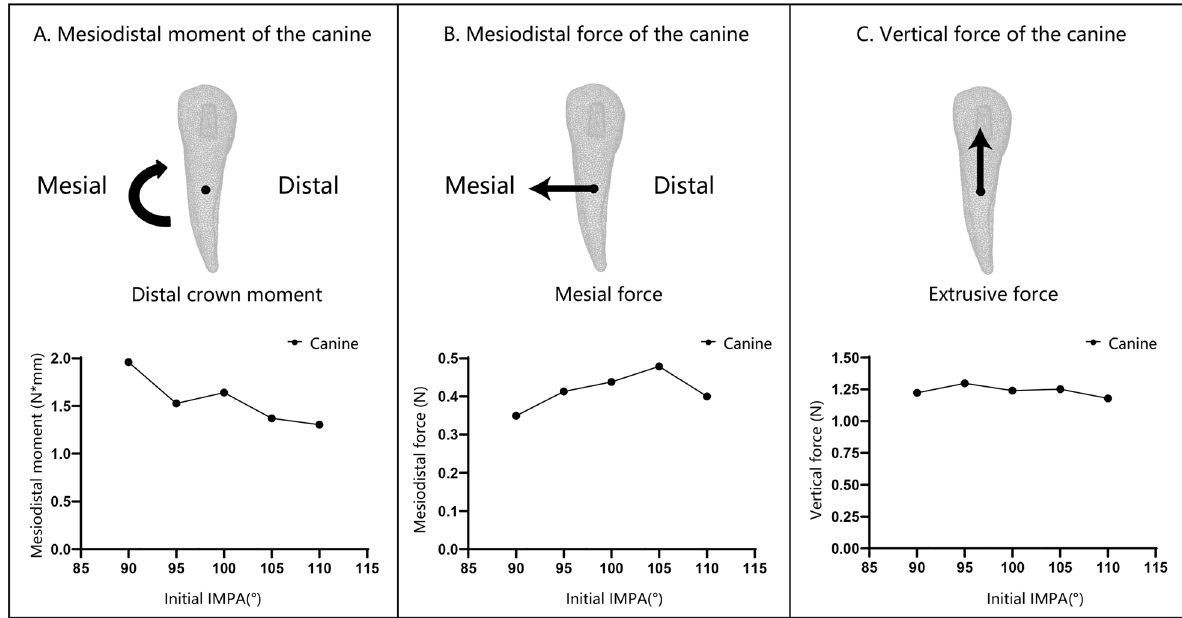
Fig. 7 Force system analysis of the canine during the intrusion of incisors. The X -axis is the initial IMPA of the incisors, and the Y -axis is the moment and the force, respectively. The black dot in the figure is the CR, and the arrow represents the direction of the moment or force. A . The mesiodistal moment of the canine: The positive value represents the distal crown moment. The canine was subjected to distal crown moment. With the increase in the IMPA, the distal crown moment decreased overall. B . The mesiodistal force of the canine: The positive value represents the force toward the mesial direction. The CR of the canine was always subjected to the force in the mesial direction, and there was no significant change with the increase in the IMPA. C . The vertical force value of the canine: The positive value represents the extrusive force. The canine was subjected to an obvious extrusive force. With the increase in IMPA, the extrusive force value showed no significant